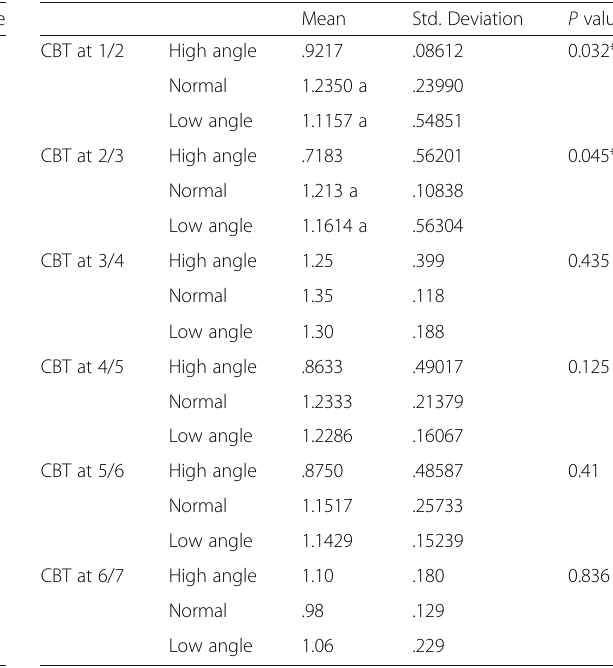
Table 4 Measurements of palatal inter-radicular cortical bone thickness at 7 mm from the alveolar crest in the upper